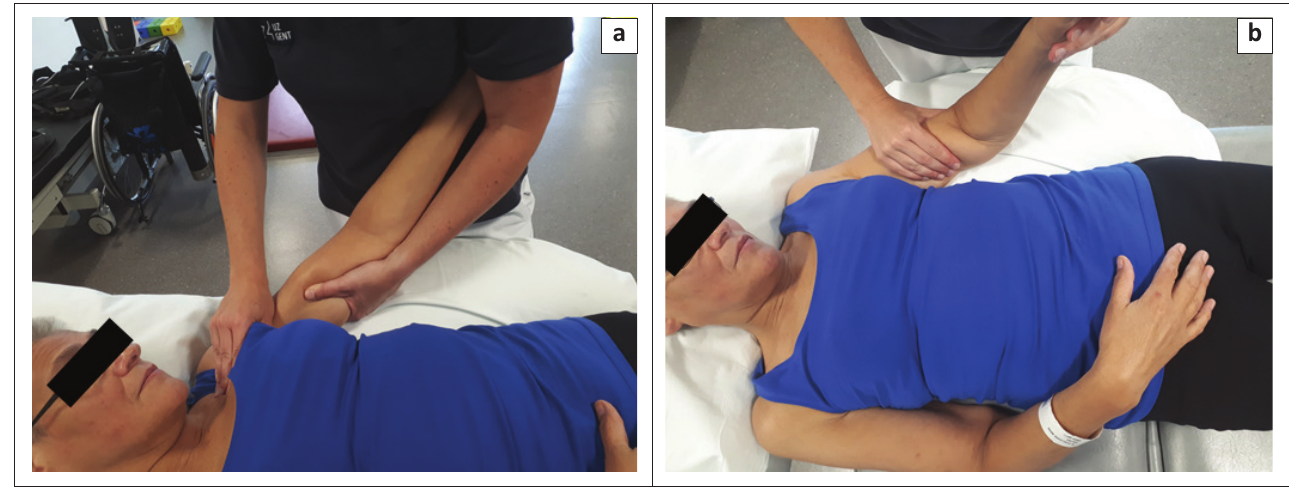
FIGURE 2: Transversal stretch of the pectoralis major (a) and biceps muscle (b) during the combined soft-tissue mobilisation technique (technique